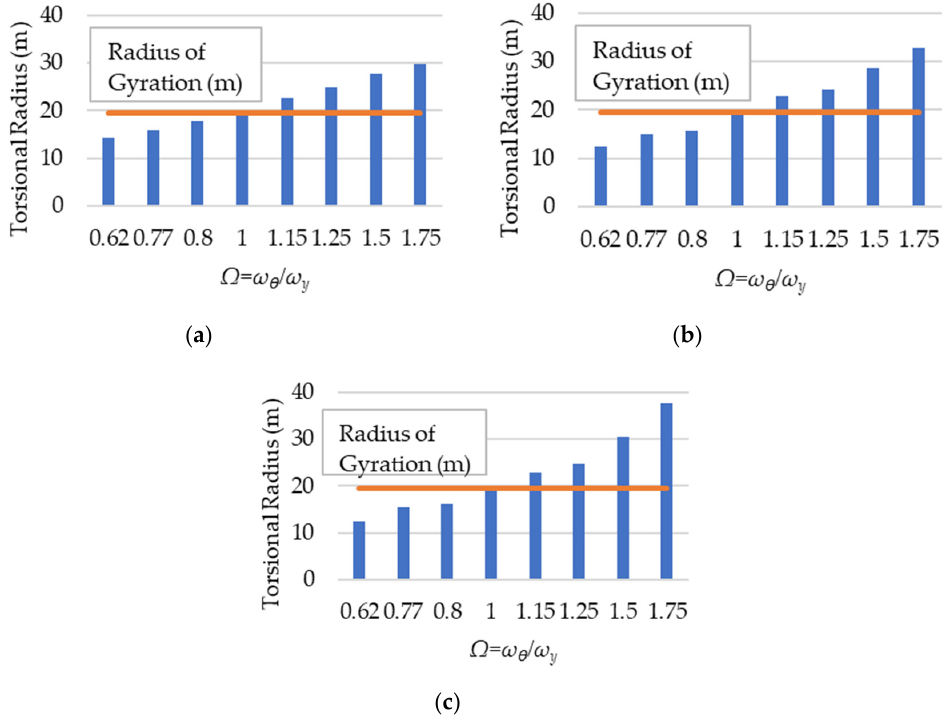
Figure 16. Torsional radius for buildings with ( r = 19.6 m & b/r = 2.45): ( a ) Building period T < 1 s; ( b ) Building period 1 < T < 2 s; ( c ) Building period T > 2 s.